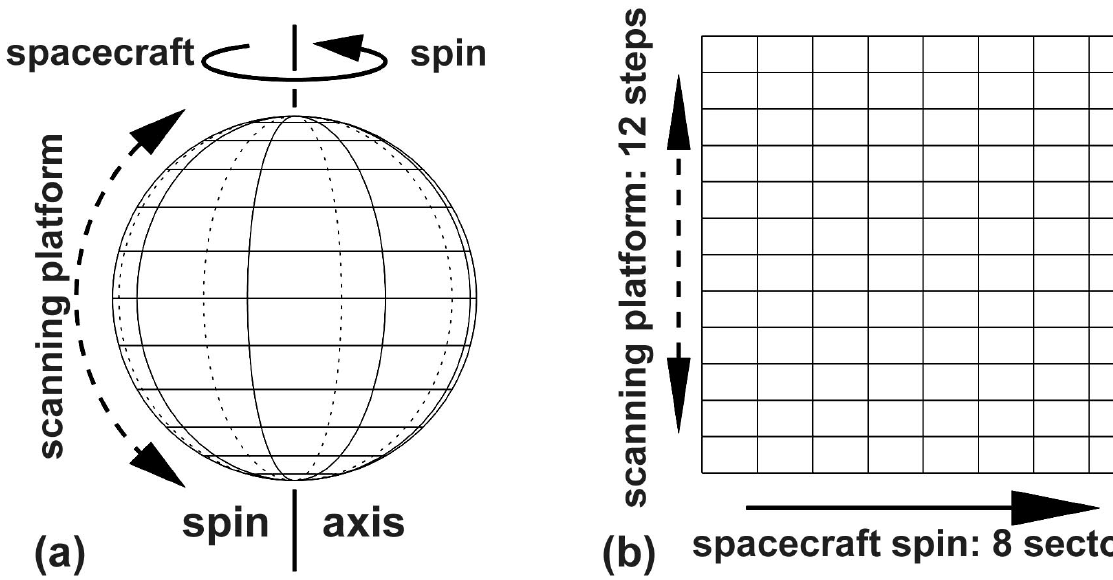
Fig. 1. (a) The measurement of all directions on the unit sphere is produced during one 36.5s spin/scan cycle of the WAPS instrument on board ISEE-1. (b) The unit sphere can be made into a mercator projection, on which pitch-angle contours and flux intensities are overlaid. The resulting plot is a pitch angle distribution (PAD) angle/angle